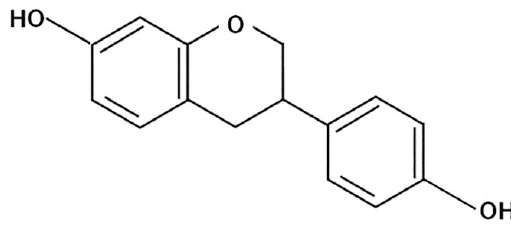
Figure 7. General structure of Figure 7. General s tructure of equol.